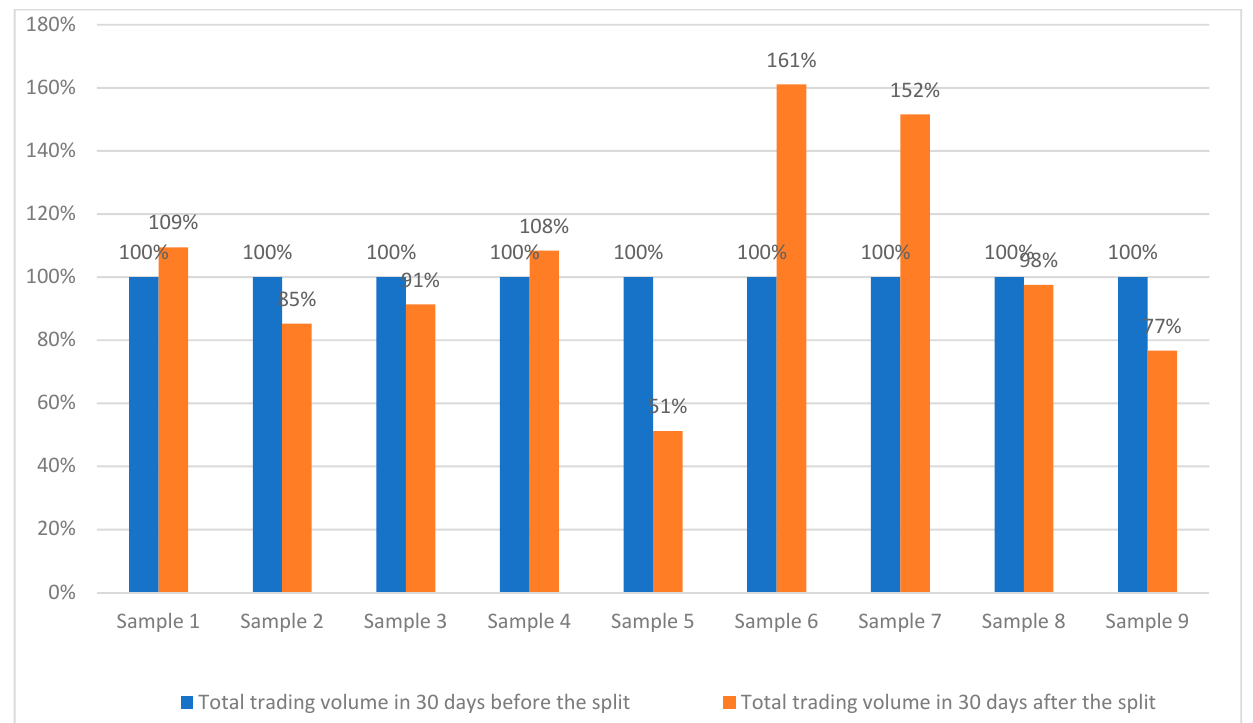
Figure 1. The total trading volume during the 30 days before (left column; blue online) and after (right column; orange online) the split. The total trading volume before the split is treated as benchmark (100%) in order to check the change in the total trading volume after the split.